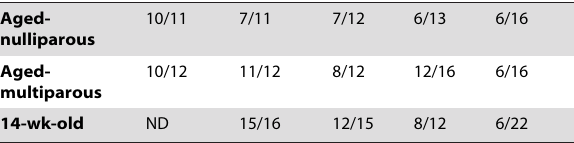
Table 2. Number of positive outgrowths (takes) originating from the implant of mammary gland cells into cleared fat